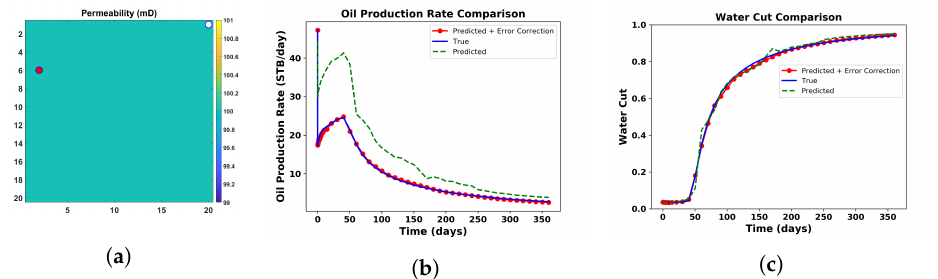
Figure 23. ( a ) Test case with a producer well location at (2,6). ( b ) Comparison of oil production rate and ( c ) comparison of water cut, predicted using the global PMOR method alone using 100 samples (dotted green line) and after the implementation of the error correction model (red circled line) with the true solution (blue